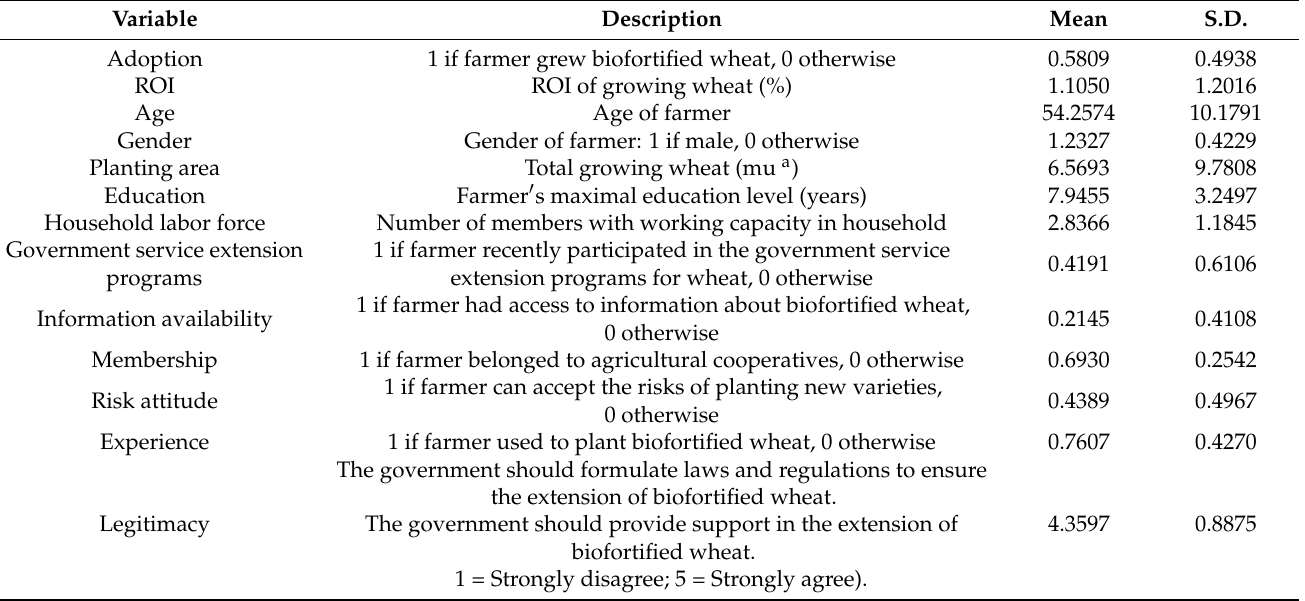
Table 1. Definition and summary statistics of selected